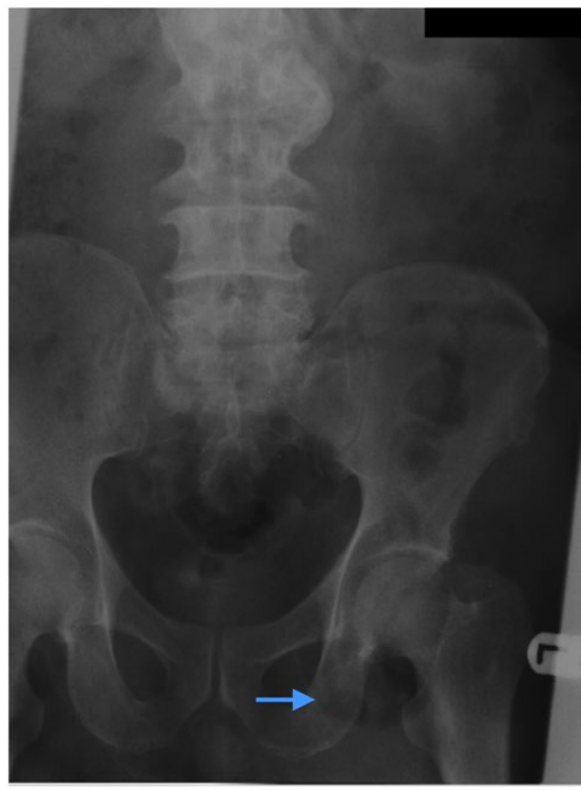
Figure 3a: Abdominal radiograph showing tubular air lucency (blue arrow) resembling bowel overlying the left inguinal region in keeping with an inguinal hernia